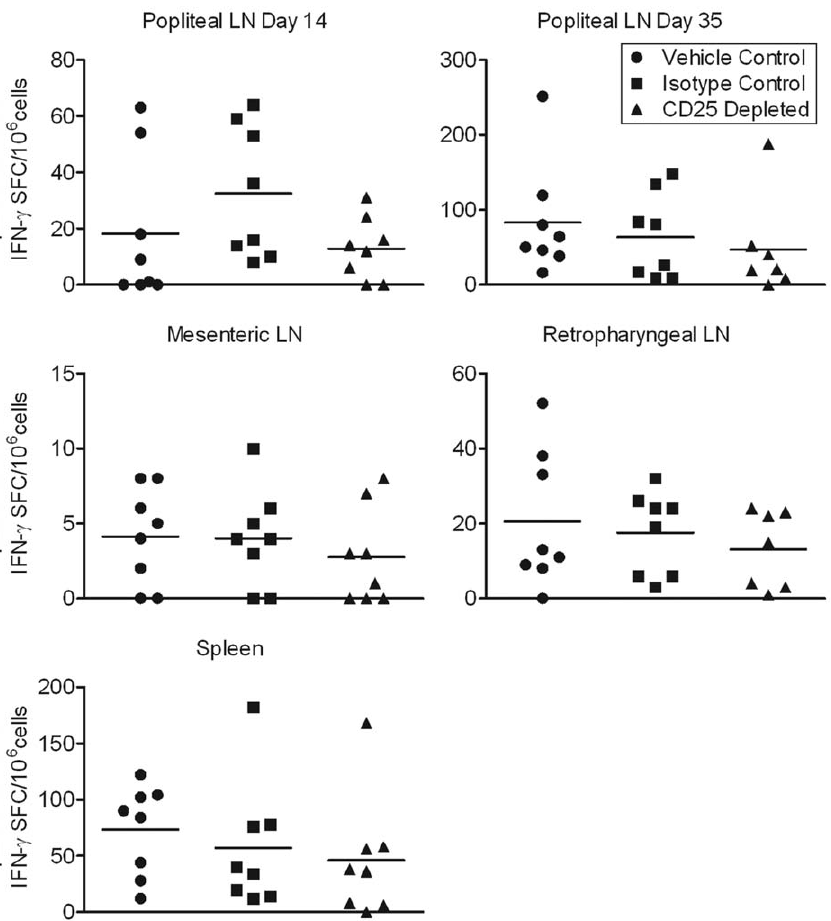
Figure 7. FIV-specific IFN- c responses during acute infection are not altered by anti-CD25 mAb treatment. Popliteal lymph node cells from day 14 and 35 p.i. and mesenteric and retropharyngeal lymph node cells and spleen cells from day 54 p.i. were incubated for 48 hours with 100 m g/mL FIV p24 peptides or 1% DMSO/media as a background control. IFN- c spot forming cells (SFCs) per million cells from CD25 depleted, isotype control, and vehicle control treated groups in response to FIV p24 minus background were determined by ELISpot